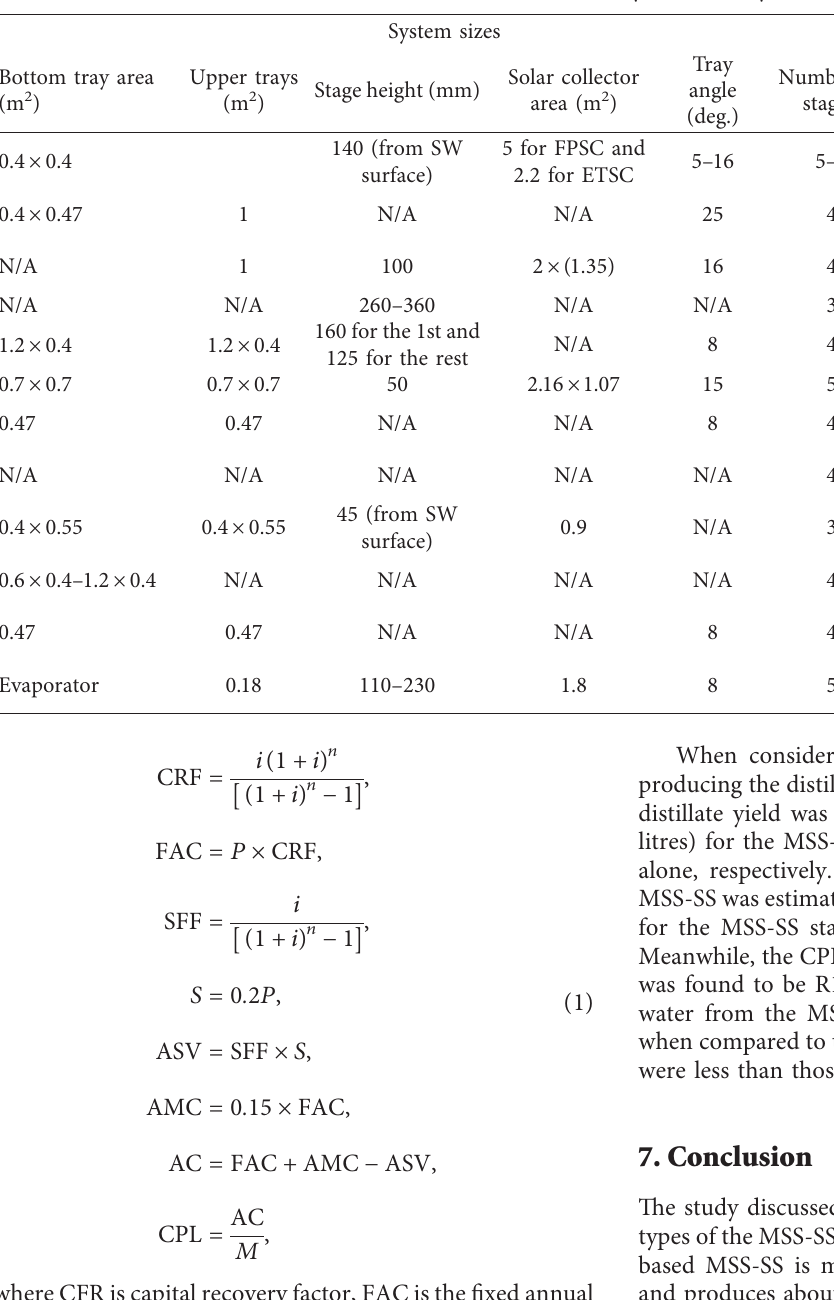
Table 4: Distillate yield